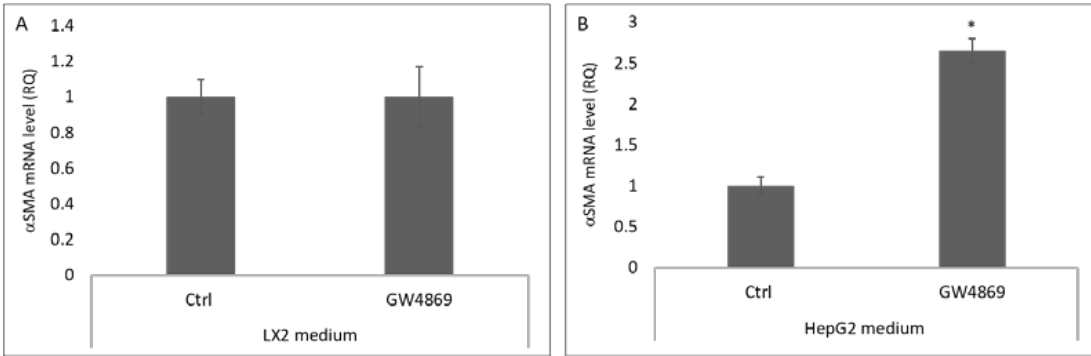
Figure 3. Effect of LX2 and HepG2 Extracellular Vesicles on αSMA in pHSCs. HepG2 and LX2 cells were incubated for 5 days with 20 µM GW4869, an inhibitor of EV secretion. pHSCs were then incubated with HepG2- or LX2-primed medium for 24 h and harvested, after which, α SMA mRNA levels were examined. ( A ) The effect of EV-free LX2-primed medium on α SMA mRNA levels in pHSCs ( B ). The effect of EV-free HepG2-primed medium on α SMA mRNA levels in pHSCs. * Significantly higher than the control, p < 0.01. ANOVA with a post-hoc Bonferroni-adjusted Student’s t -test.